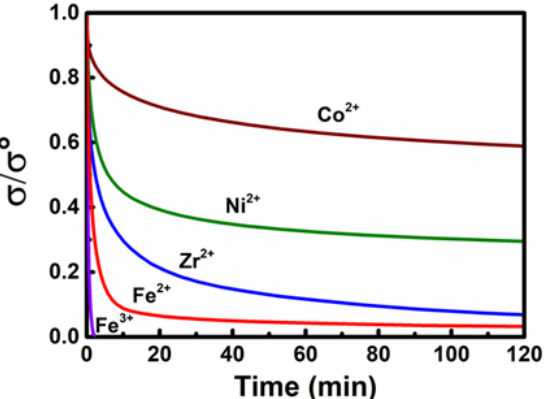
Figure 4. The stress relaxation kinetics of different metal ions doped samples at 60 °C. σ represents the instantaneous stress and σ° represents the initial stress.